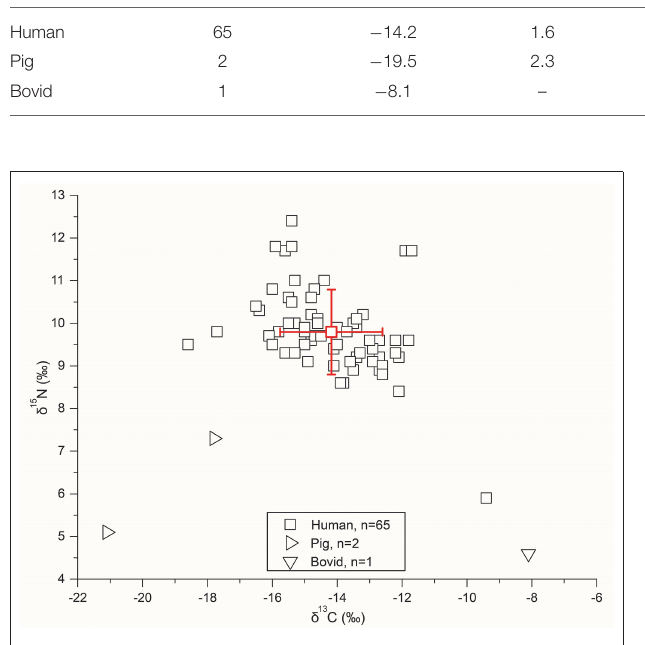
FIGURE 2 | Scatter diagram of carbon (C) and nitrogen (N) isotopes values for human and animal bone collagen.